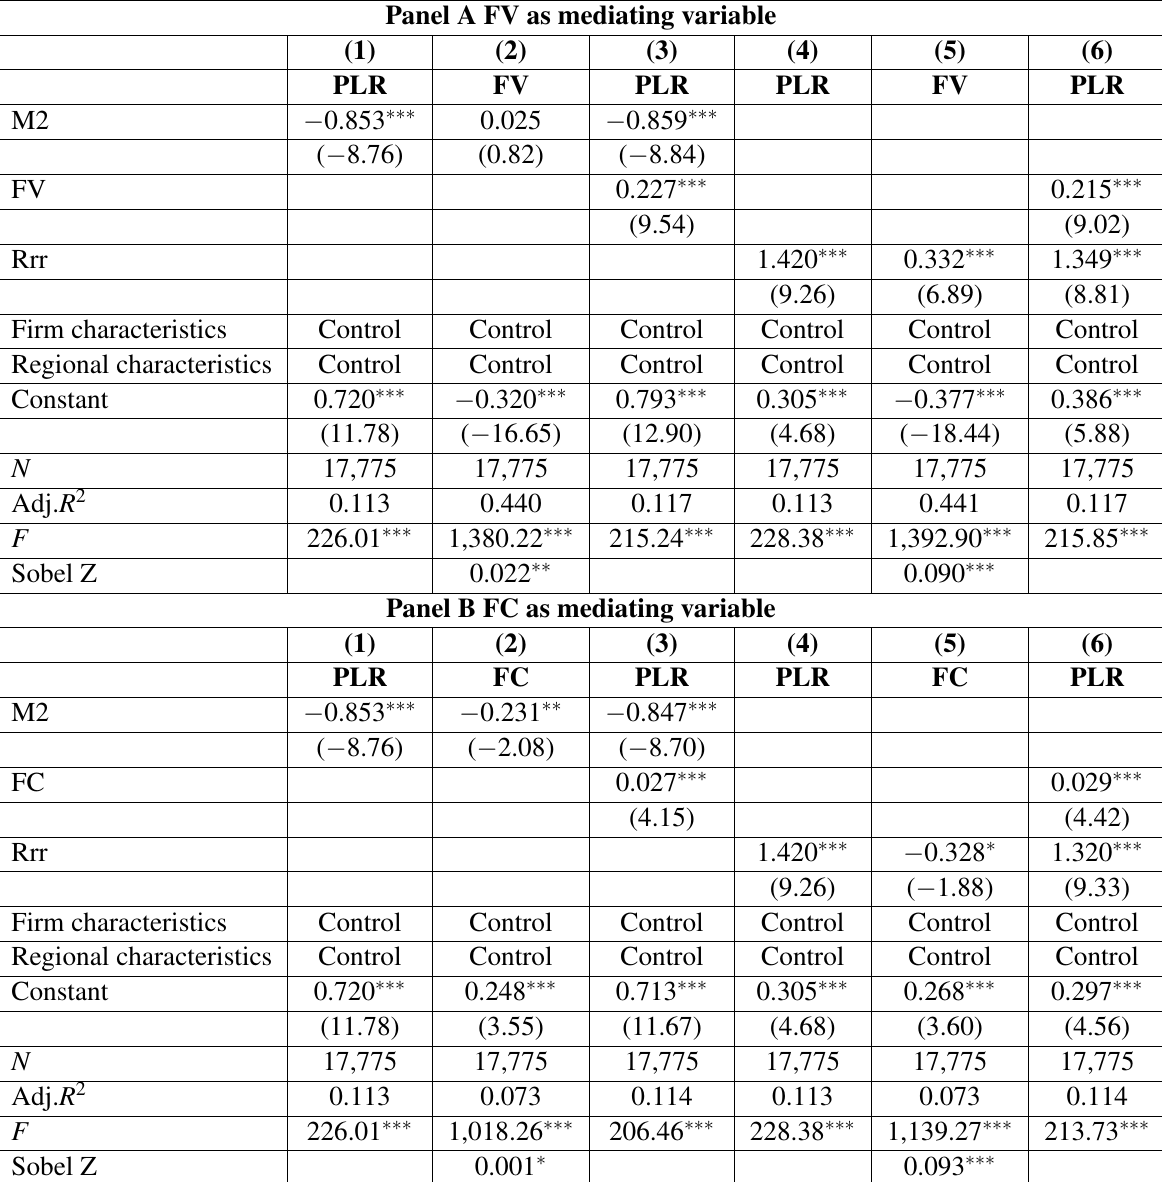
Table 9 Mediating effect